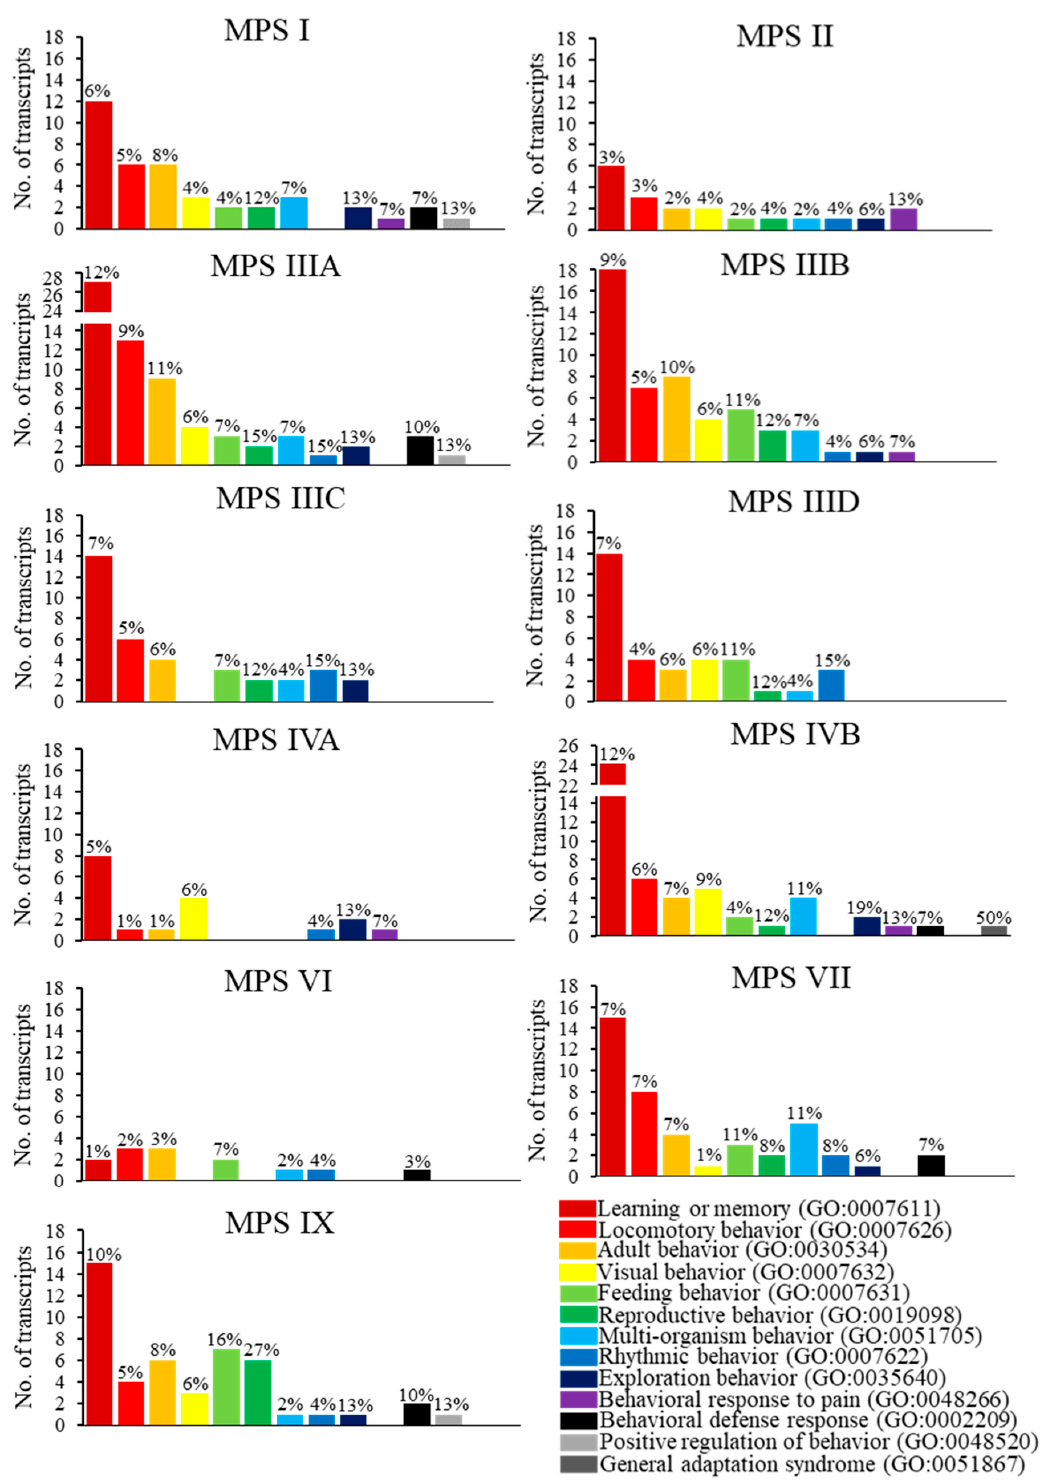
Figure 2. Number of transcripts, corresponding to genes from indicated sub-processes (child processes) of behavior (term GO:0007610), defined according to the QuickGO database, which levels were significantly changed in MPS cells (MPS type or subtype is indicated in each panel) relative to the control cells. Fractions (%) of genes represented in each given GO term being differentially expressed relative to HDFa are also demonstrated above corresponding columns. Each sub-process is indicated by different color, according to the legend presented in the right-lower corner.